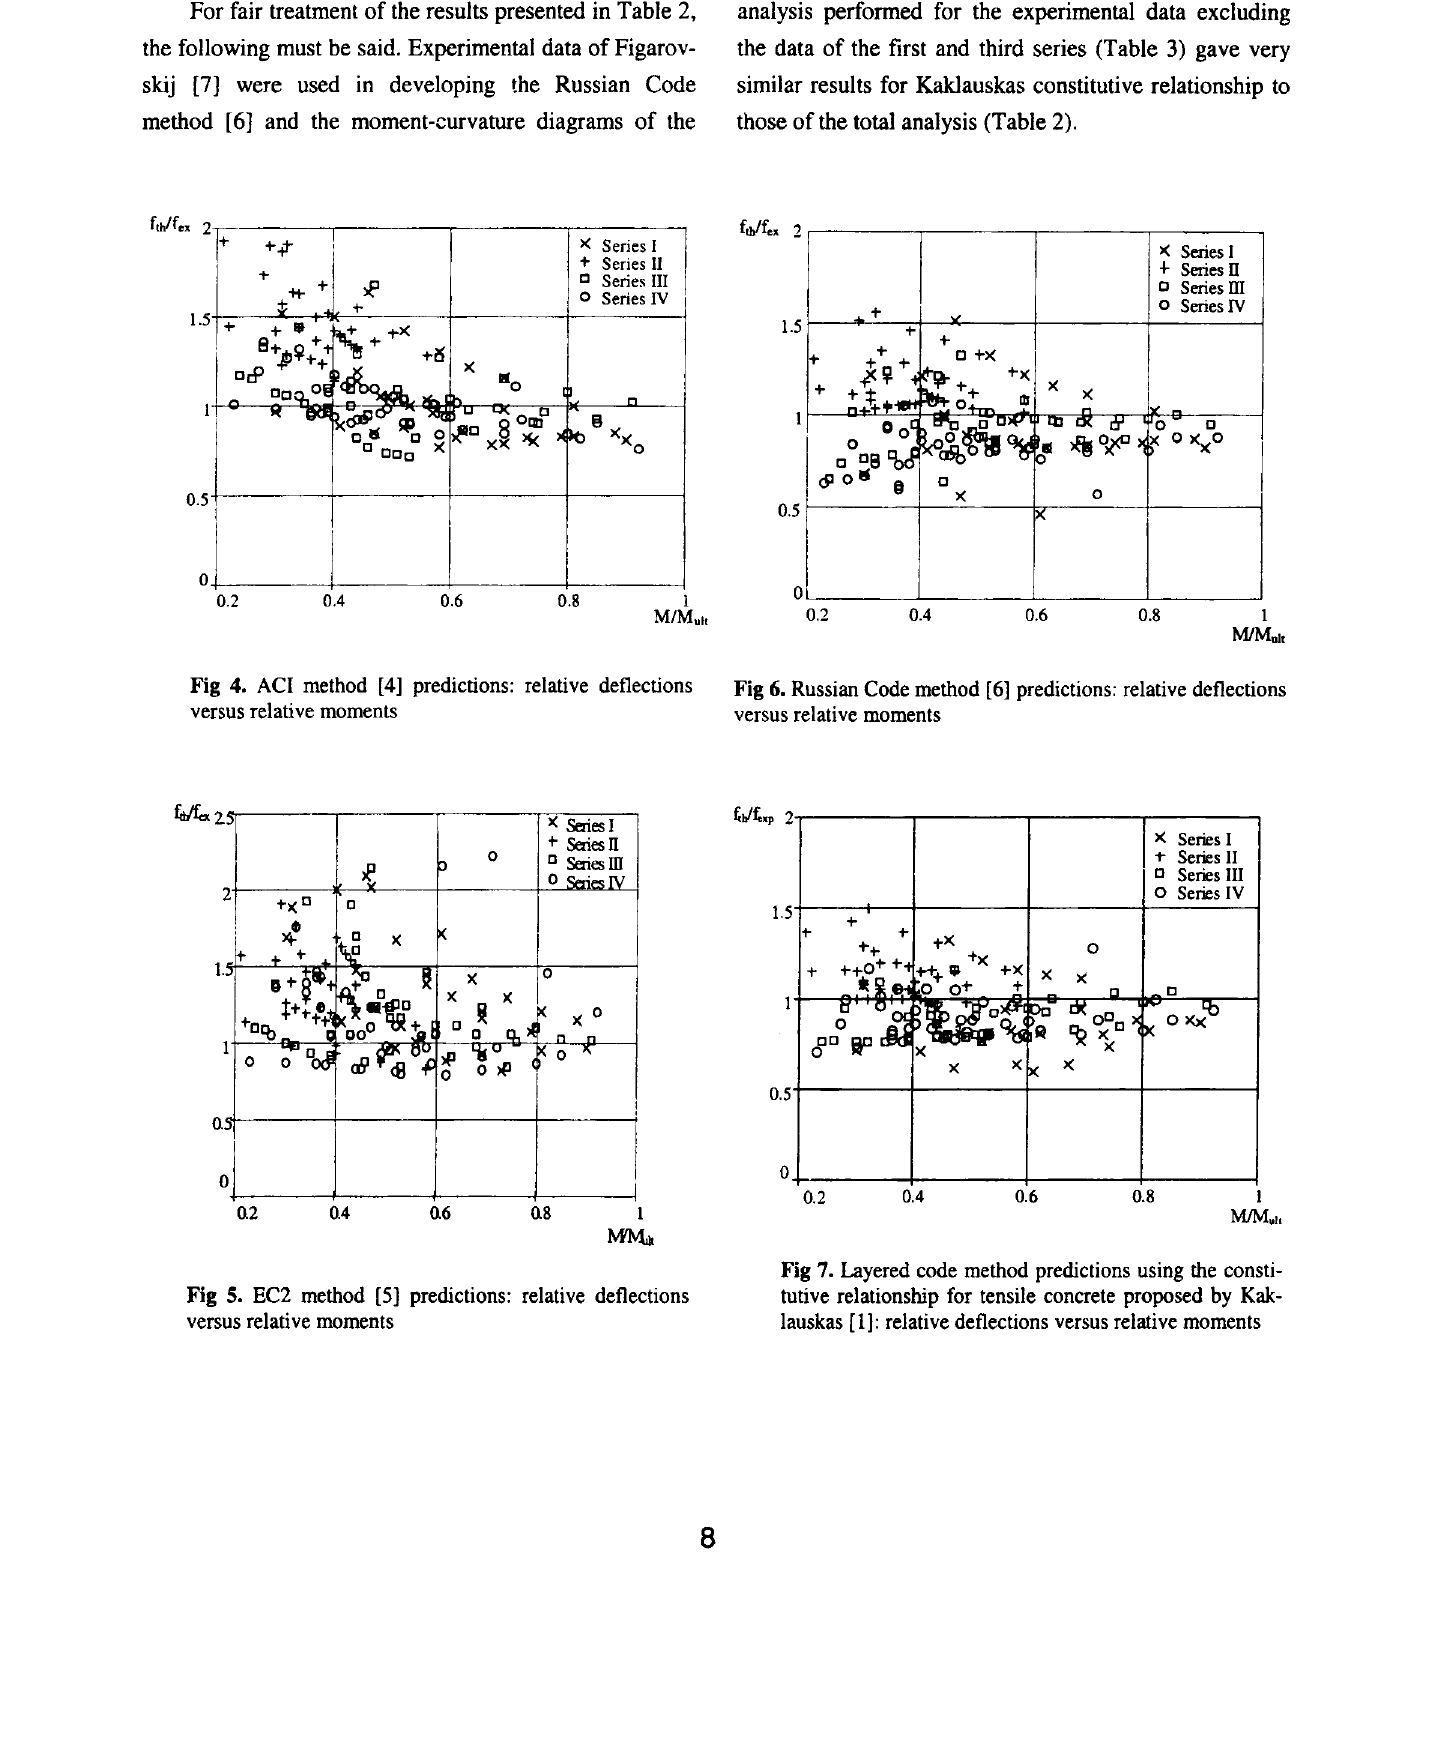
Fig S. EC2 method [5] predictions: relative deflections versus relative moments